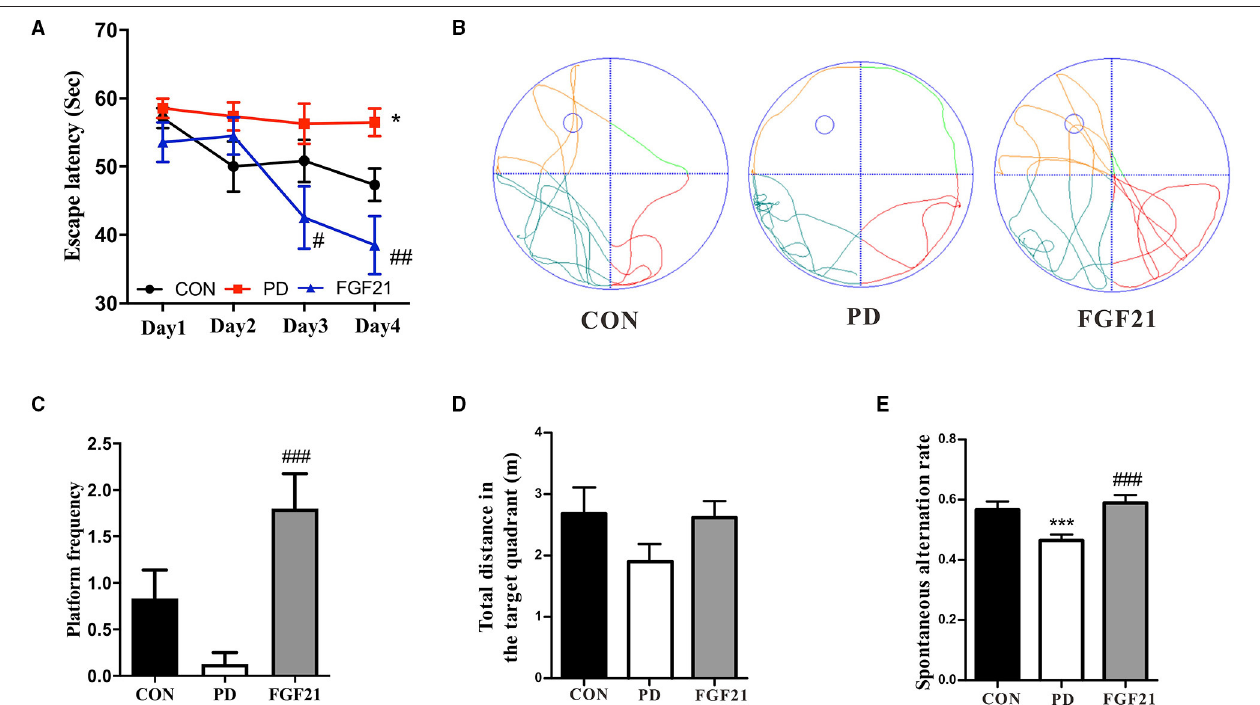
FIGURE 2 | FGF21 treatment prevented the cognitive deficits of mice with PD. (A) Escape latency during 4 training days. (B) Representative swim paths. (C) Distance in the target quadrant. (D) Number of crossing the place of the platform. (E) Spontaneous alteration in the Y-maze. Data are mean ± s.e.m.; n = 6–8 for each group. A one-way ANOVA was used for statistical analysis followed by an LSD multiple comparison test. * P < 0.05, *** P < 0.001 vs. CON group; # P < 0.05, ## P < 0.01, ### P < 0.001 vs. MPTP-injected